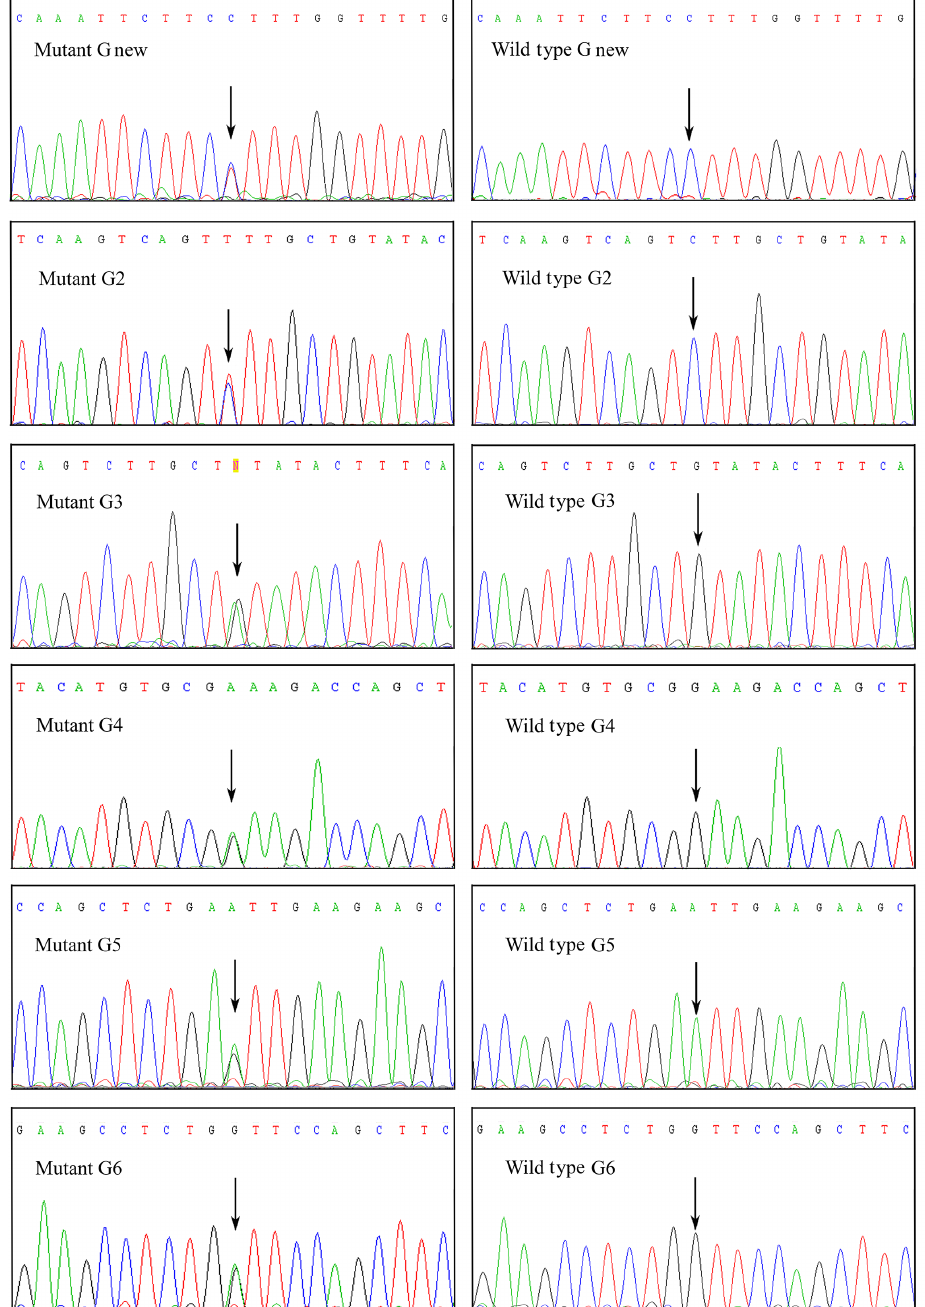
Figure 1. Graphical representation of detected mutations in GDF9 DNA of Iranian twin-birth ewes compared to sequence ID gb | AF078545.2 | AF078545. G0 (C25T) is the newly detected mutation; G2–G6 were previously defined by Hanrahan et al. (2004)